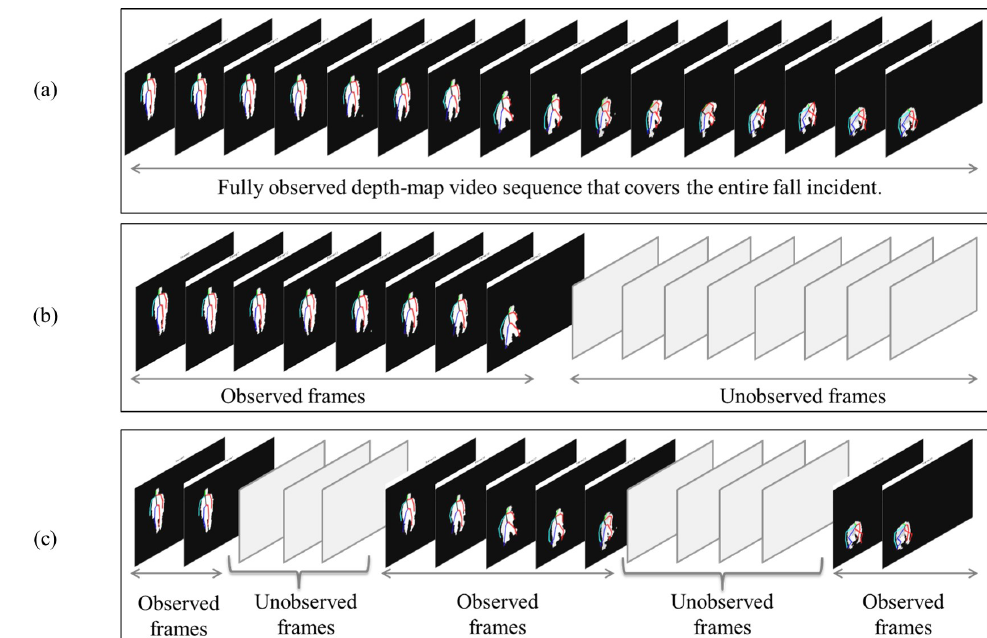
Figure 1. Illustration of the different fall detection schemes. ( a ) Fall detection using a complete depth-map video sequence in which the frames cover the entire fall incident [30]; ( b ) Fall prediction using incomplete depth-map video sequence in which a subset of frames that cover the beginning of the fall incident is observed, while the frames that cover the rest of the fall incident are not observed [27]; ( c ) Fall detection using a partially-observed depth-map video sequence in which the observed frames cover discontinuous parts of the fall